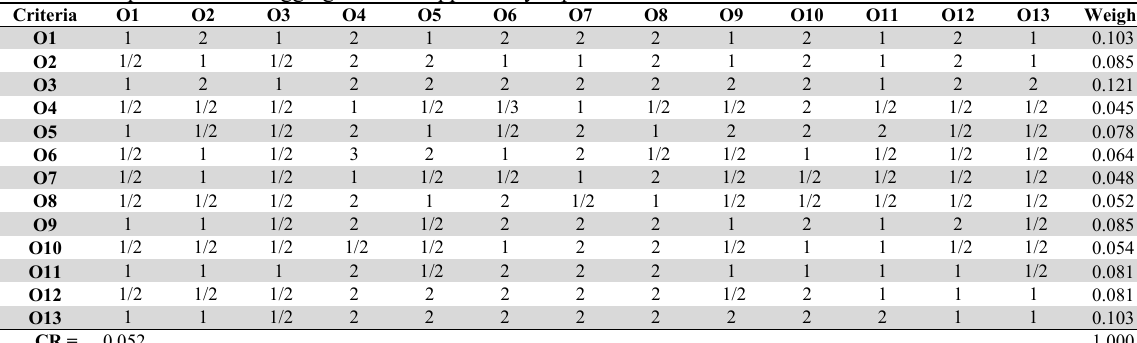
Pairwise comparison matrix aggregation for Opportunity aspects Criteria